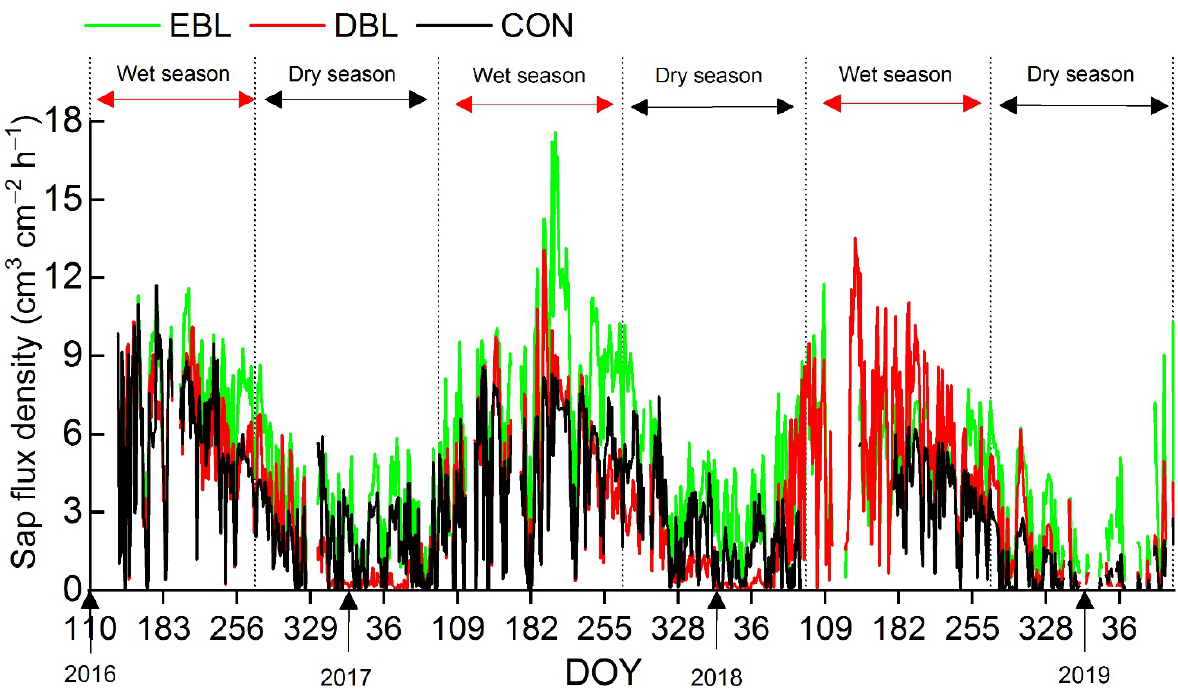
Figure 2. Daily average of sap flux densities in evergreen broad-leaved trees (EBL), deciduous broad-leaved trees (DBL), and conifers (CON) between May 2016 and March 2019. Missing data were due to instrument or power failure.